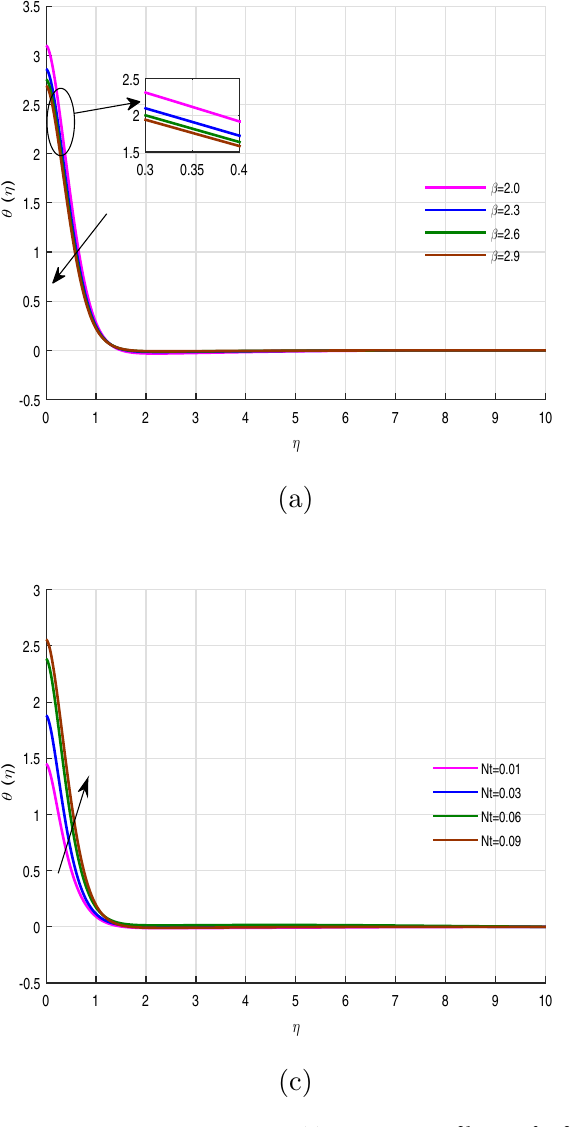
Figure 4. Temperature profile θ(η) for fixed values of physical parameters (cid:31) = 0.1 k = 8.933 , Pr = 6.0 , M = 0.5 , Gr = 0.09 , Gc = 0.05 , σ 1 = 1.1 , σ 2 = 10.9 , R = 0.5 , Ec = 0.6 , Nb = 0.01 , Nt = 0.1 Sc = 9.0 , fw = 1.0 , ϕ = 0.2 , n = 0.01 and β = 2.5